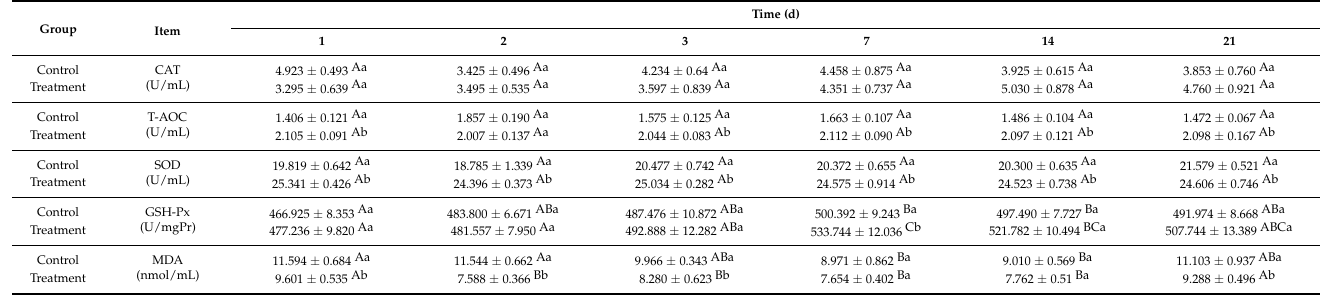
Table 4. The effects of experimental feed on antioxidant capacity in blood of perinatal female goats.